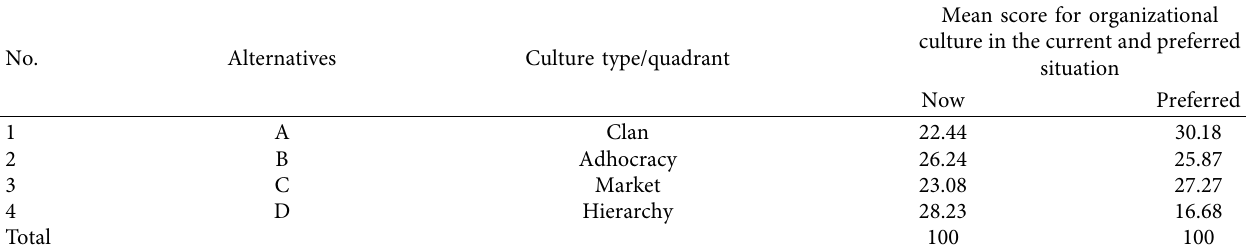
Table 5: Summary of respondents’ perceptions on dominant organizational